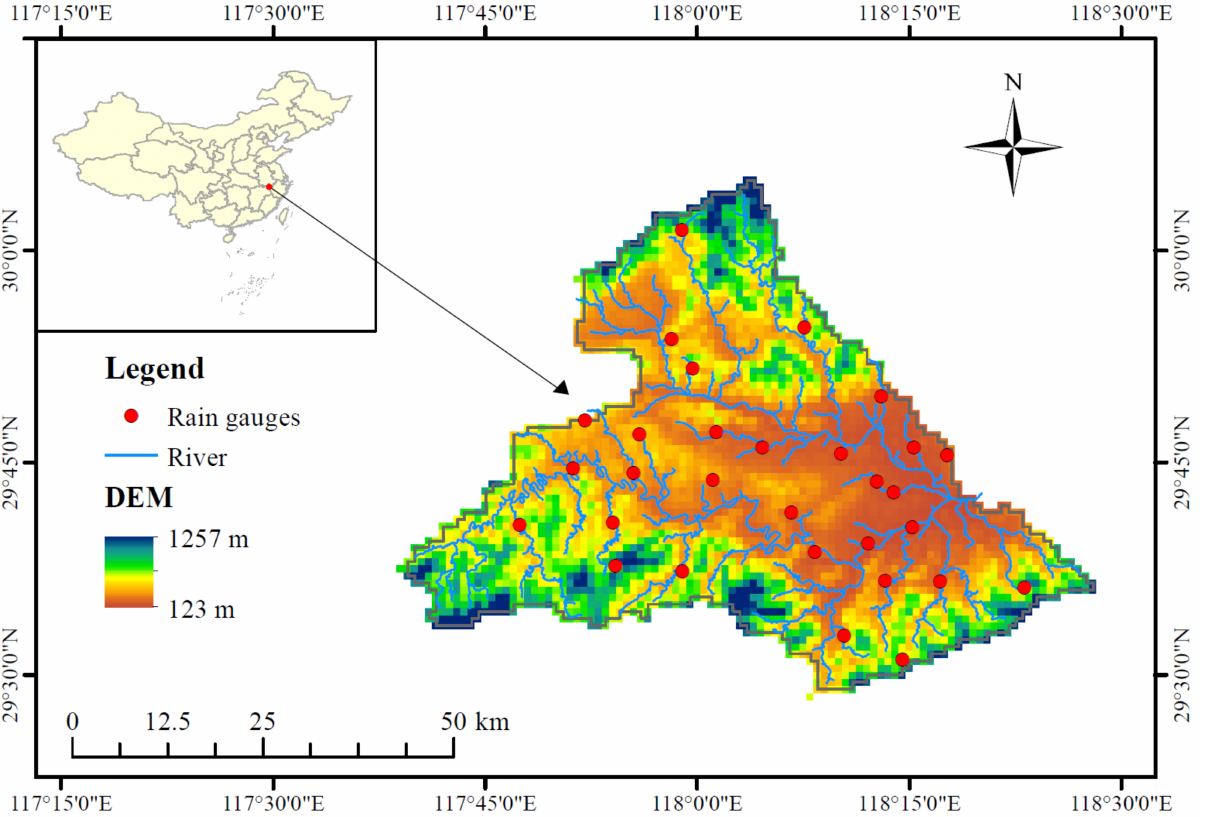
Figure 1. Location of the Tunxi Watershed and the distribution of rain